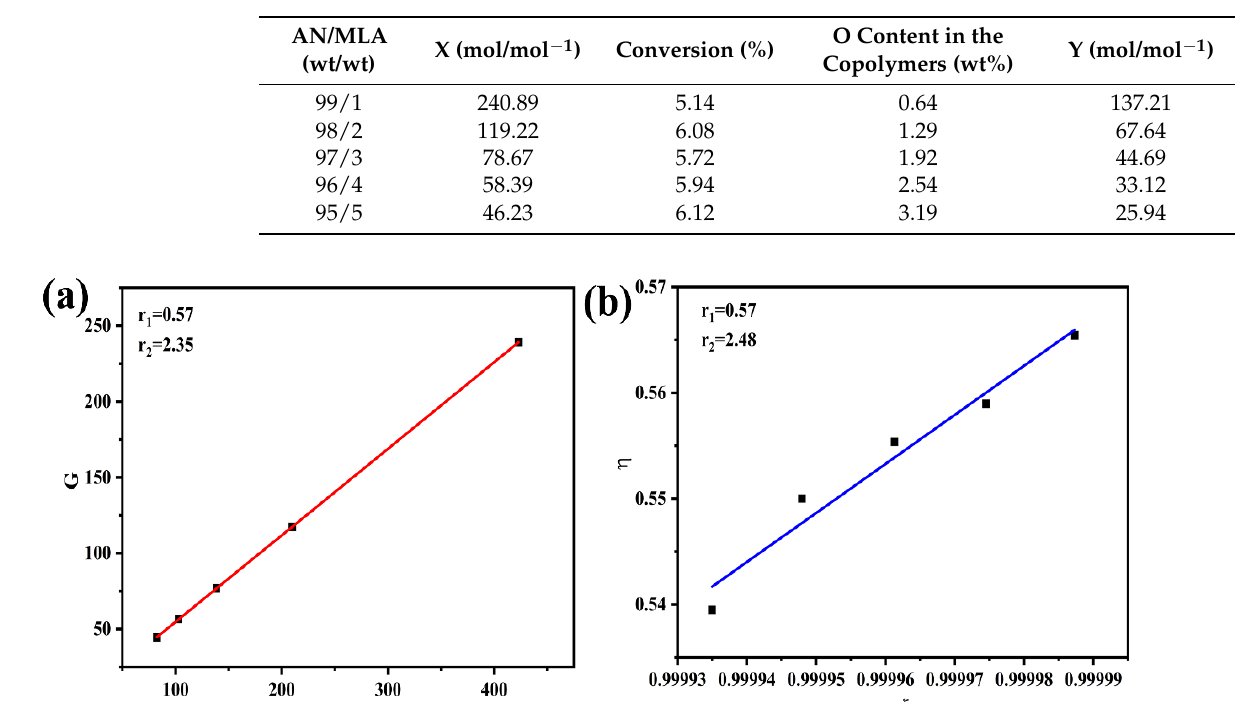
Figure 1. The monomer reactivity ratios calculated by ( a ) Fineman–Ross method and ( b ) Kelen–Tüdõs method.